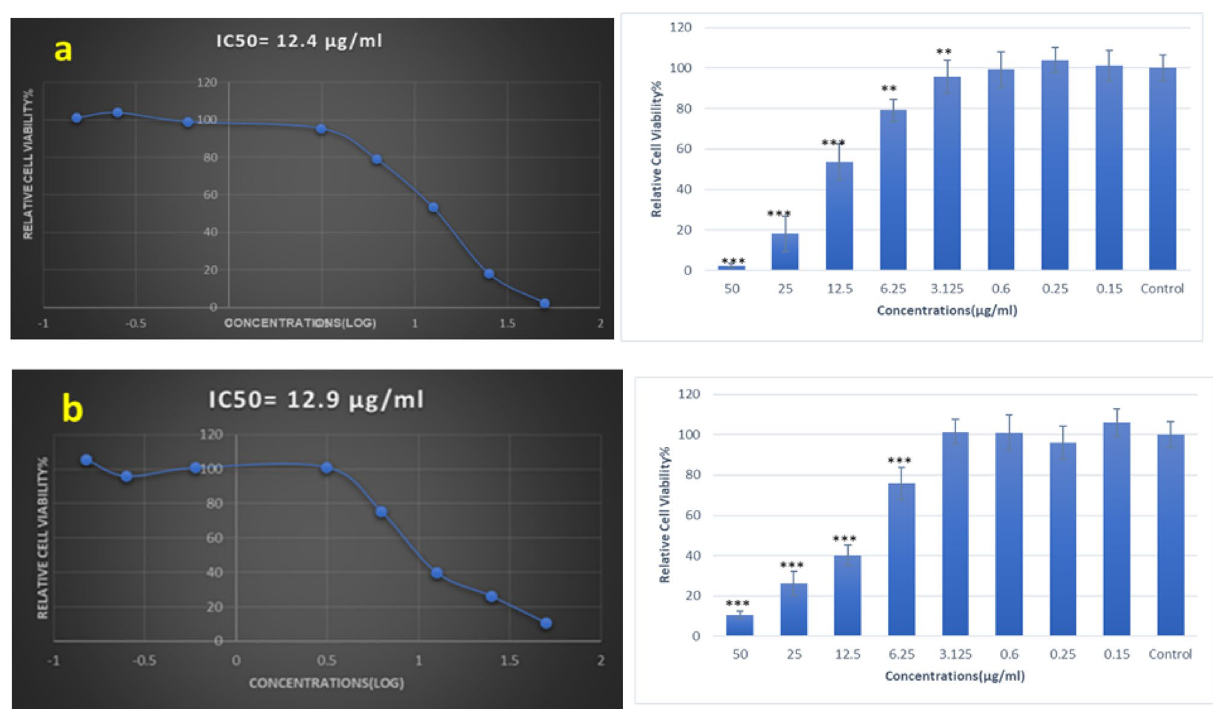
Figure 14. The viability of MCF-7 cancer cells, 24 h after treatment with ZnTPP/Cu-NPs (3) ( a ) and ZnTPP/ Cu-NPs-PAA (3) ( b